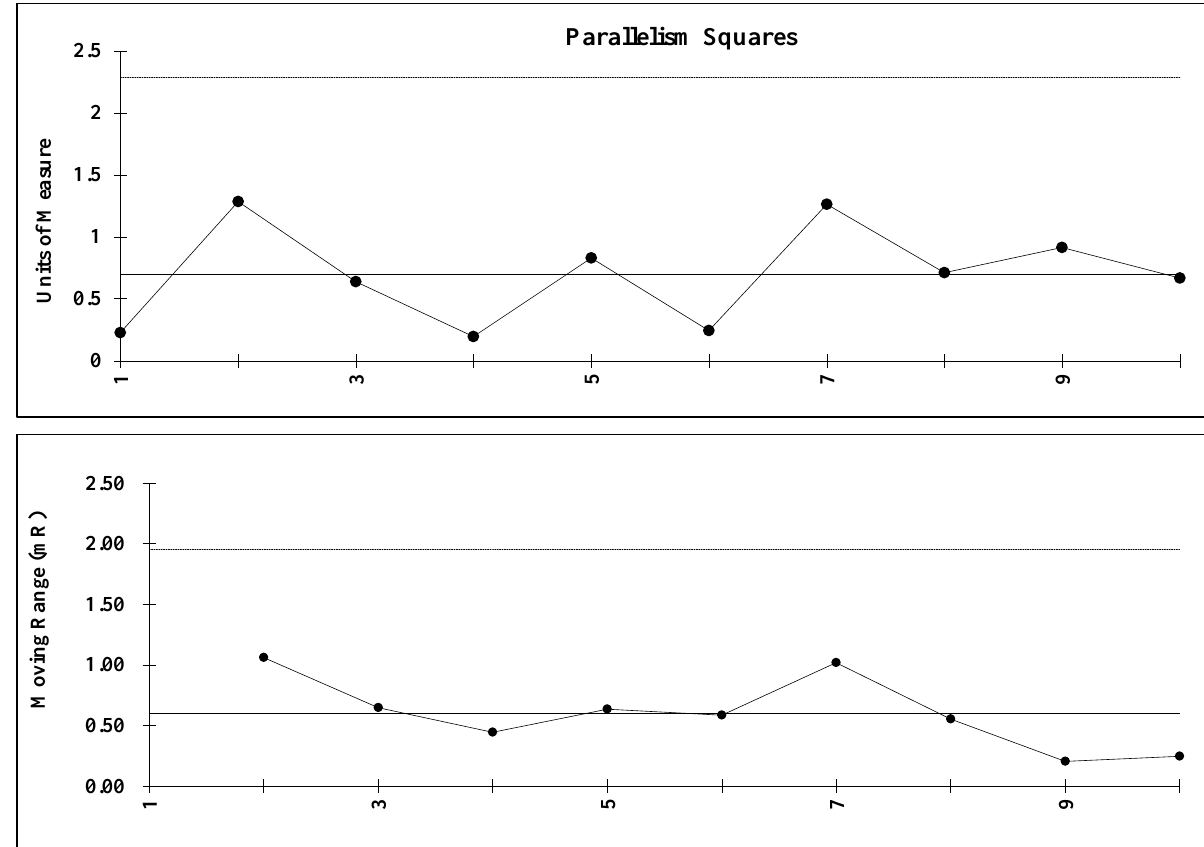
Figure 6. I-MR (XmR) control charts for laboratory self-assessment of the running microbiological assay suitability: regression squares and parallelism